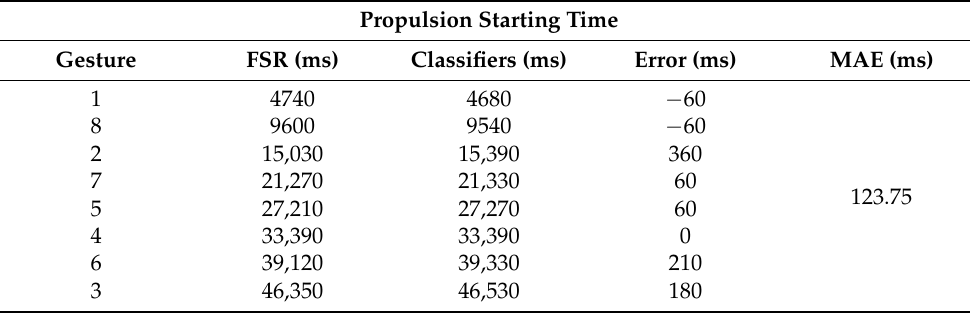
Table 8. Propulsion starting time results from WISP and force sensors.